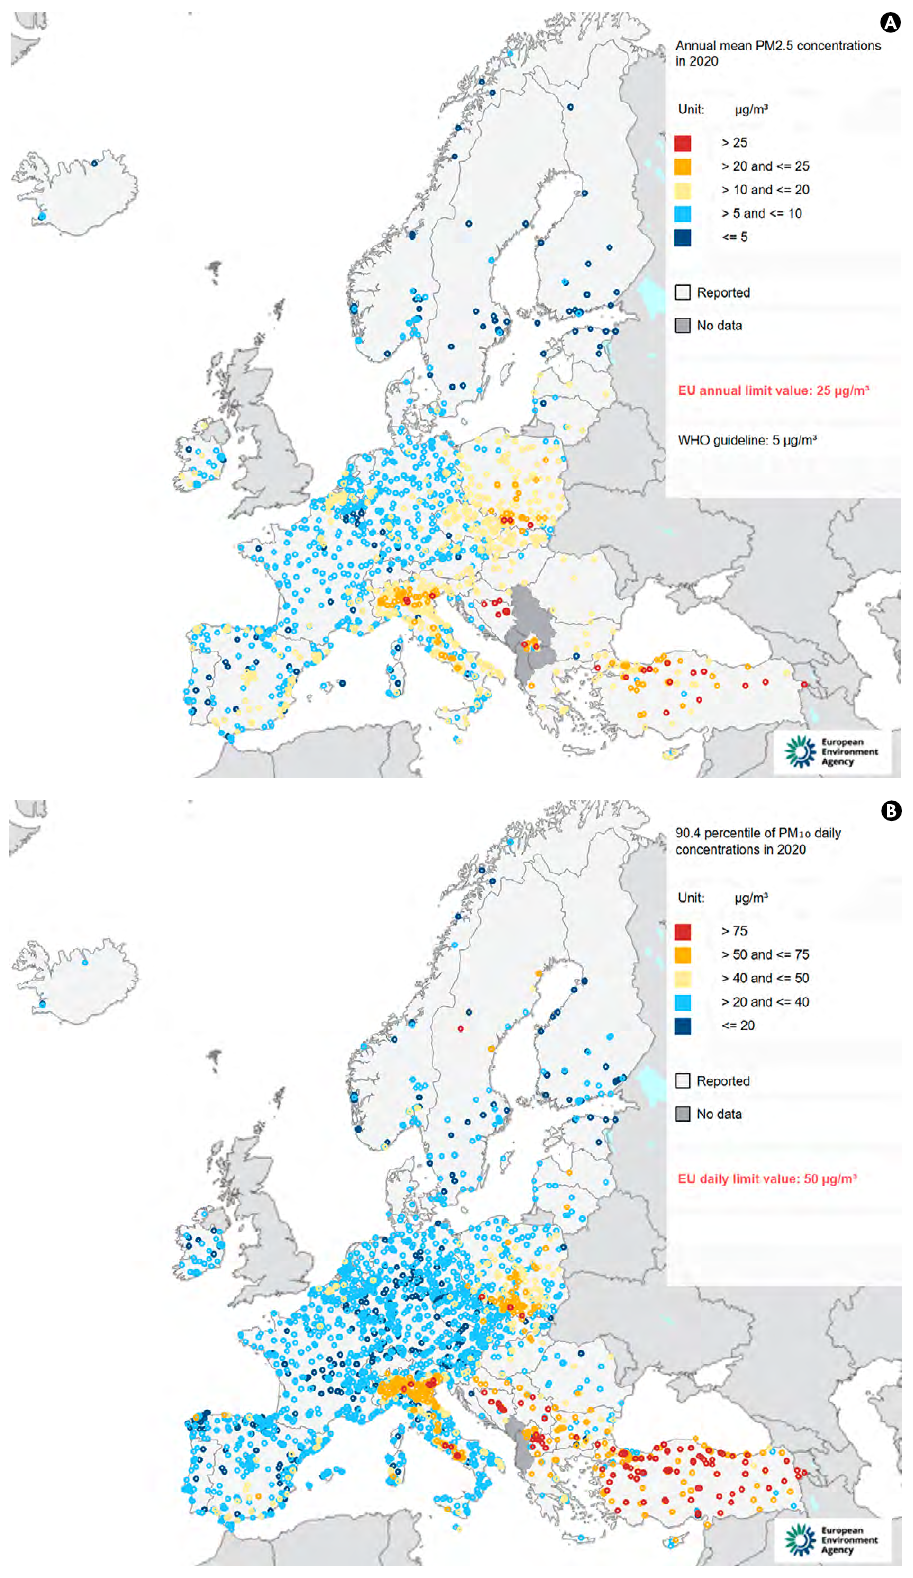
Figure 4. A) Concentration of PM2.5 in European countries for 2020 (validated data) in relation to the EU and WHO standards. Six countries reported PM2.5 concentration above the EU limit (25 μg/m 3 ), and only Estonia did not report PM2.5 concentration higher than the WHO standard (5 μg/m 3 ); B) Concentration of PM10 in European countries for 2020 (validated data) in relation to the EU and WHO standards. 20 countries reported PM10 concentration above the EU standard (50 μg/m 3 ), and only Iceland did not report PM10 concentration above the WHO standard (15 μg/m 3 ) Source: